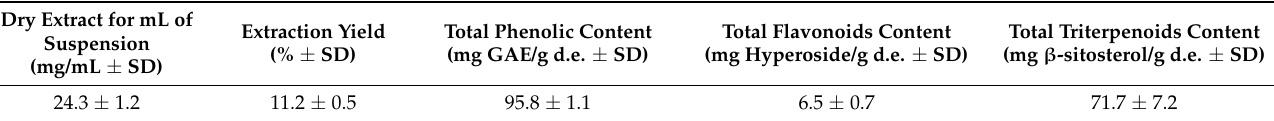
Table 1. Extraction yield, total phenolic, flavonoids and triterpenoids content. Results are expressed as mean value ± standard deviation (SD) from three different preparations.